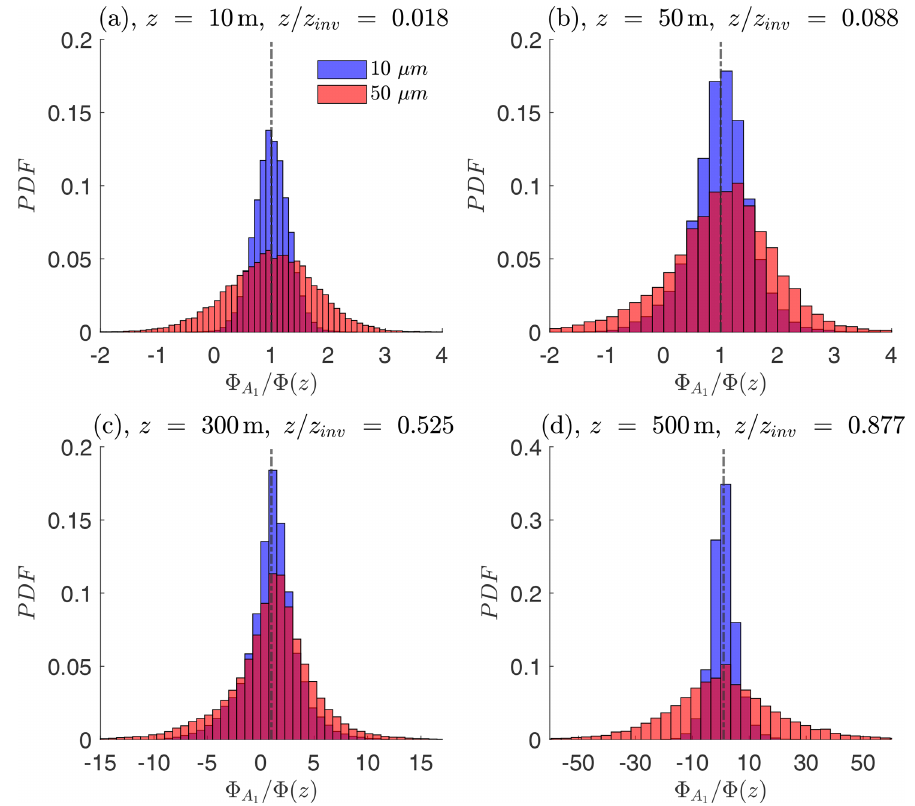
Figure 7. Probability density function of 10µm (red) and 50µm (blue) aerosol particle fluxes at z = 10m (a) , z = 50m (b) , z = 300m (c) , and z = 500m (d) for A 1 . The pink probabilities signify the overlap of fluxes between the two